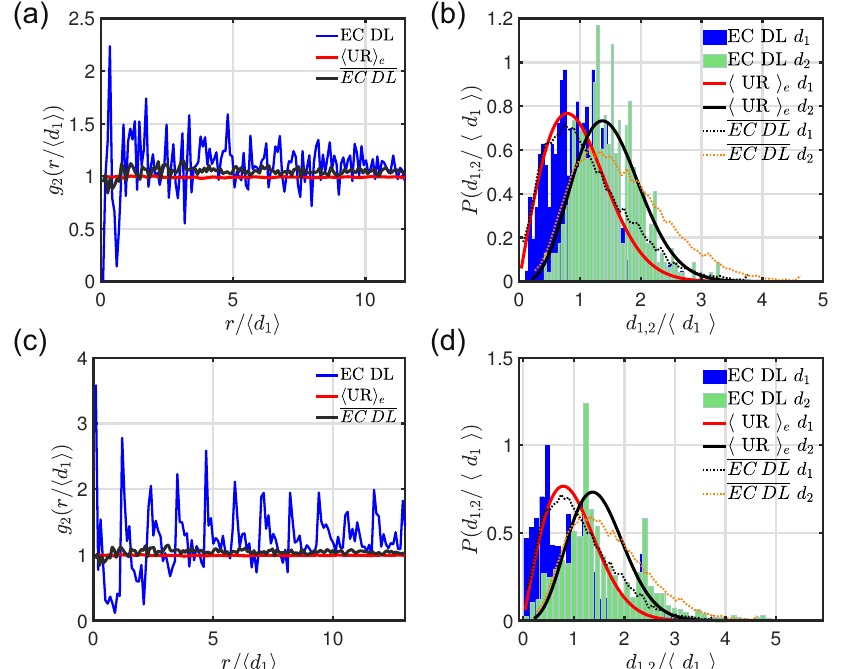
Figure 8. Panels ( a , b ) and panels ( c , d ) report the radial distribution function g ( r ) and the first and second neighbor probability density function of the EC DL point patterns reported in Figure 1 panels ( c , d ), respectively. Moreover, their averaged values, with respect to 72 different EC DL geometries (generated by randomly selecting the starting point W from the elliptic curve point patterns generated by the coefficients combination ( a = 27; b = 4 ) and ( a = 28; b = 19 ) , named EC H and EC L respectively), are compared with respect the UR